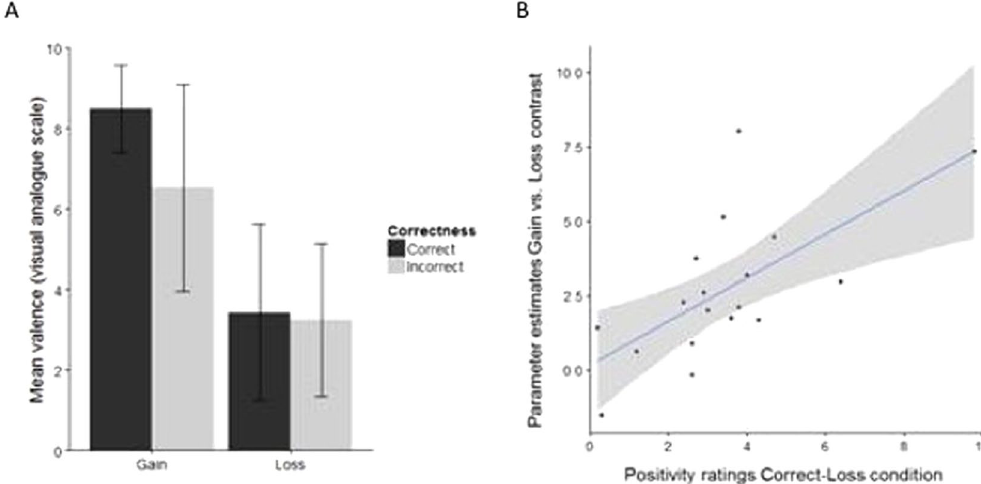
Figure 5. ( A ) Mean positivity ratings (ranging from 0–10) provided by the fMRI participants for the four different outcomes. Error bars depict standard deviations. ( B ) Scatterplot depicting the relationship between individual striatal activations for gain vs loss and the positivity ratings for the Correct-Loss condition (with regression line and 95% confidence band). Rating data from one participant is missing.